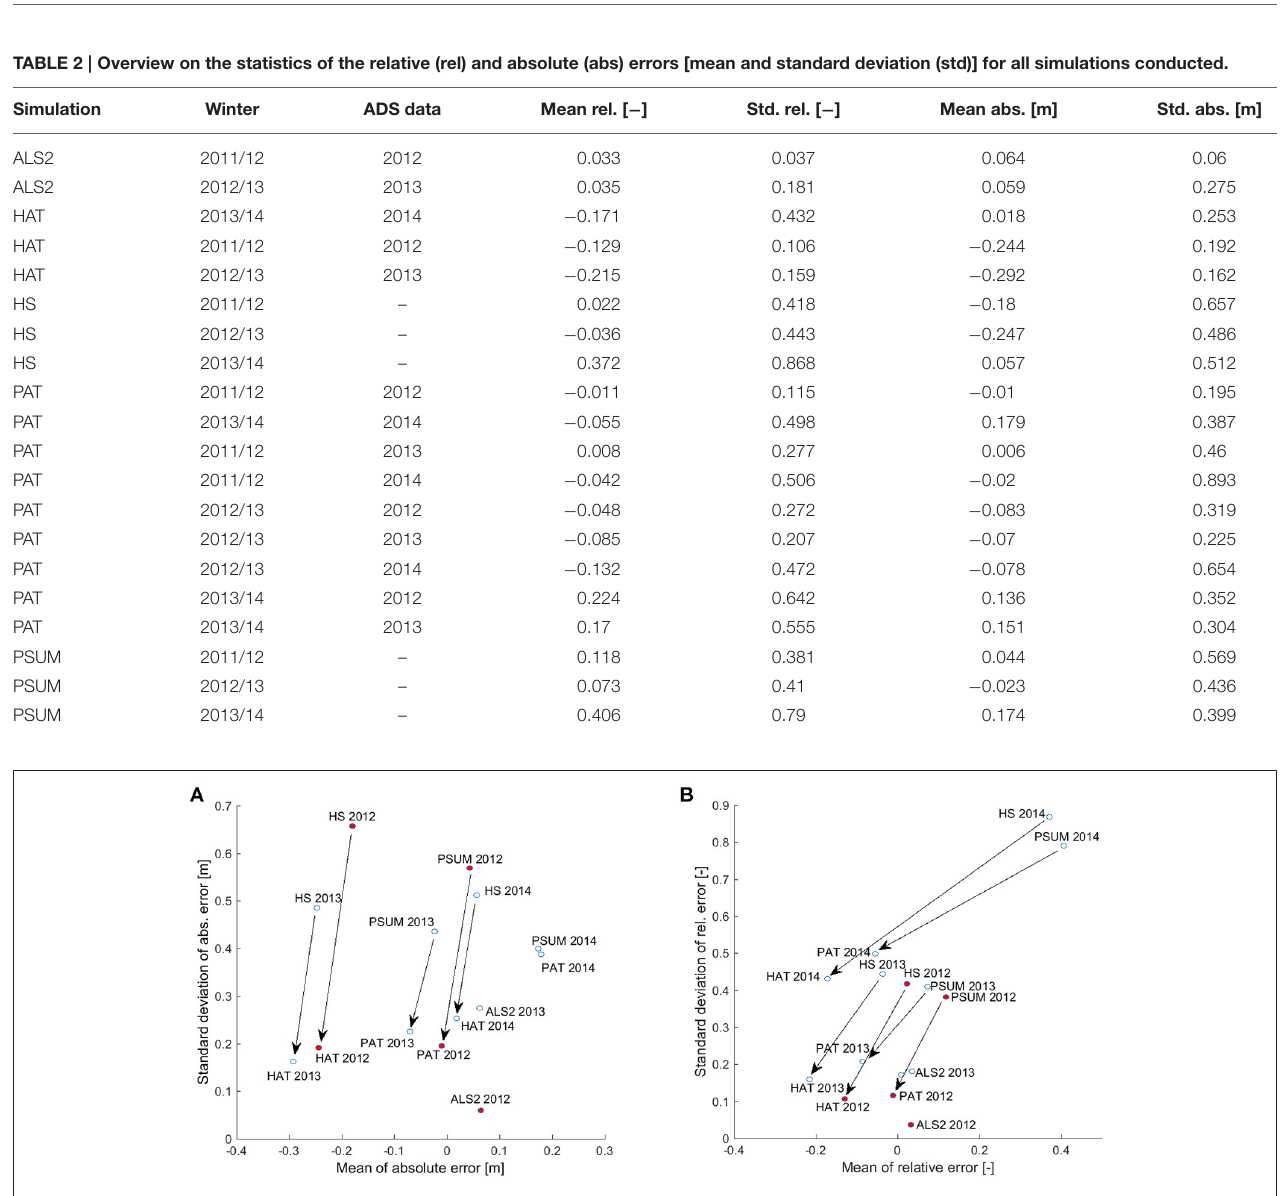
FIGURE 5 | (A) Plot of mean absolute error and standard deviation, (B) Plot of the mean relative error and standard deviation for non-scaling and scaling simulations for the winters 2011/12, 2012/13, and 2013/14. Arrows indicate the effect of the scaling. Simulations from winter 2011/12 are colored in